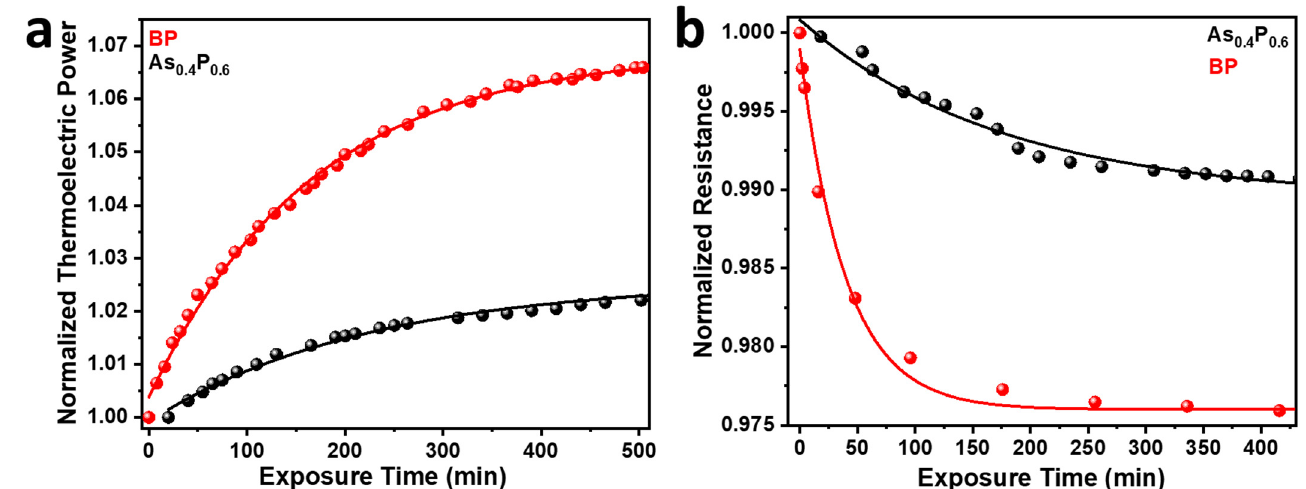
Figure 4. Results derived from electrical transport measurements of exposed samples after anneal- ing. ( a ) Normalized TEP for As (cid:2868).(cid:2872) P (cid:2868).(cid:2874) and BP. ( b ) Normalized resistance for As (cid:2868).(cid:2872) P (cid:2868).(cid:2874) and BP. ( a ) Normalized TEP for As 0.4 P 0.6 and BP. ( b ) Normalized resistance for As 0.4 P 0.6 and